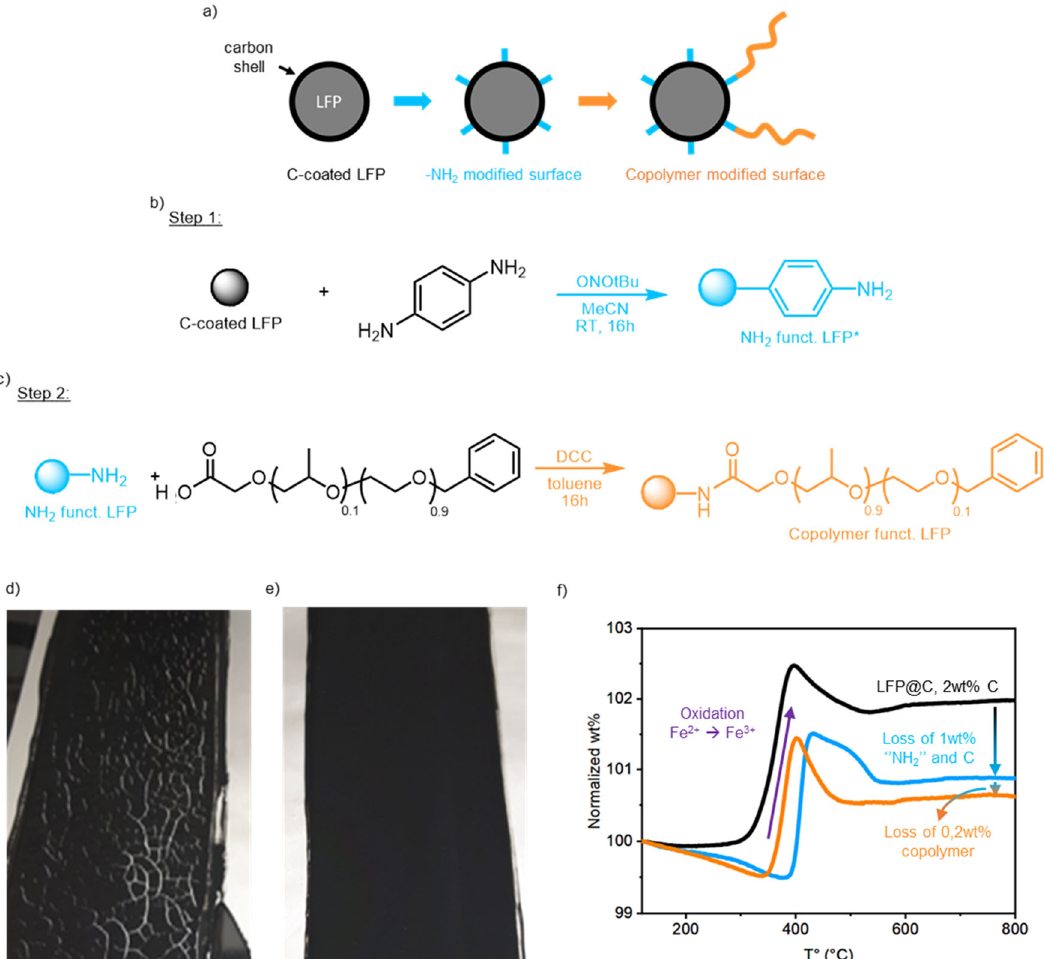
Fig. 6 Carbon-coated lithium iron phosphate (C-coated LFP) particles surface functionalization. a Schematized general procedure. b Step 1: NH